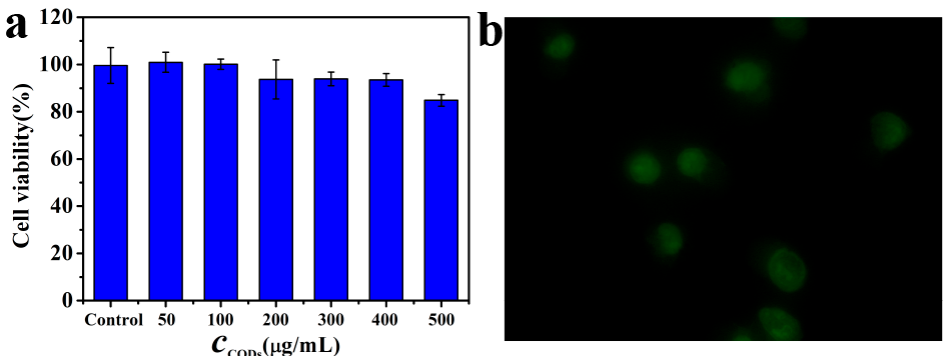
Figure 3. ( a ) Cellular toxicity of P-doped CQDs on BV2 microglioma cell viability. ( b ) Cells imaged by excitation at the WIBA channel.